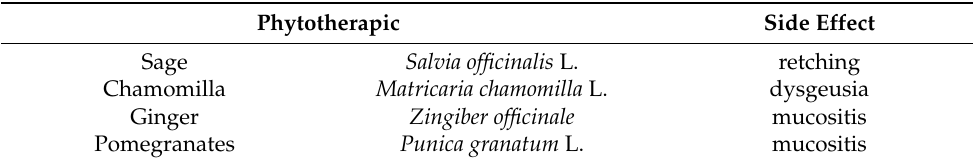
Table 3. List of phytotherapics resulting in risk factors of gastrointestinal side